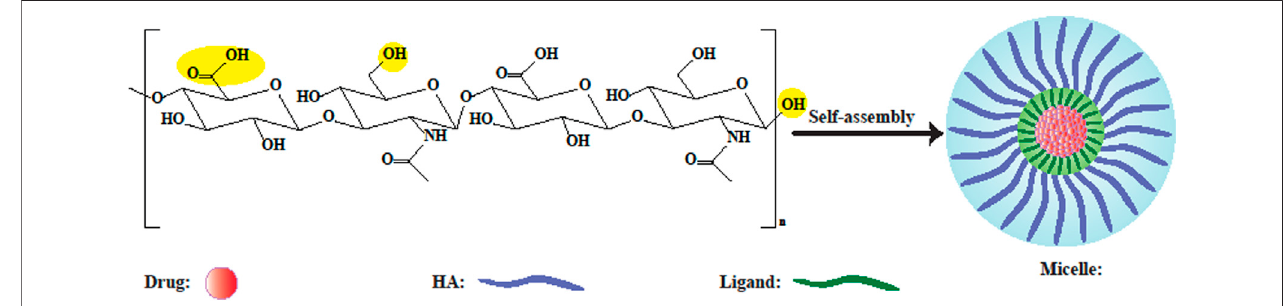
FIGURE 4 | Schematic illustration of HA-based polymeric micelles. Yellow circles depict probable sites for modi fi cation. In aqueous solution, self-assembled micelles can be formed by conjugating amphiphilic HA-ligands to hydrophobic drugs, or by encapsulating drugs inside them (Kim et al., 2019).